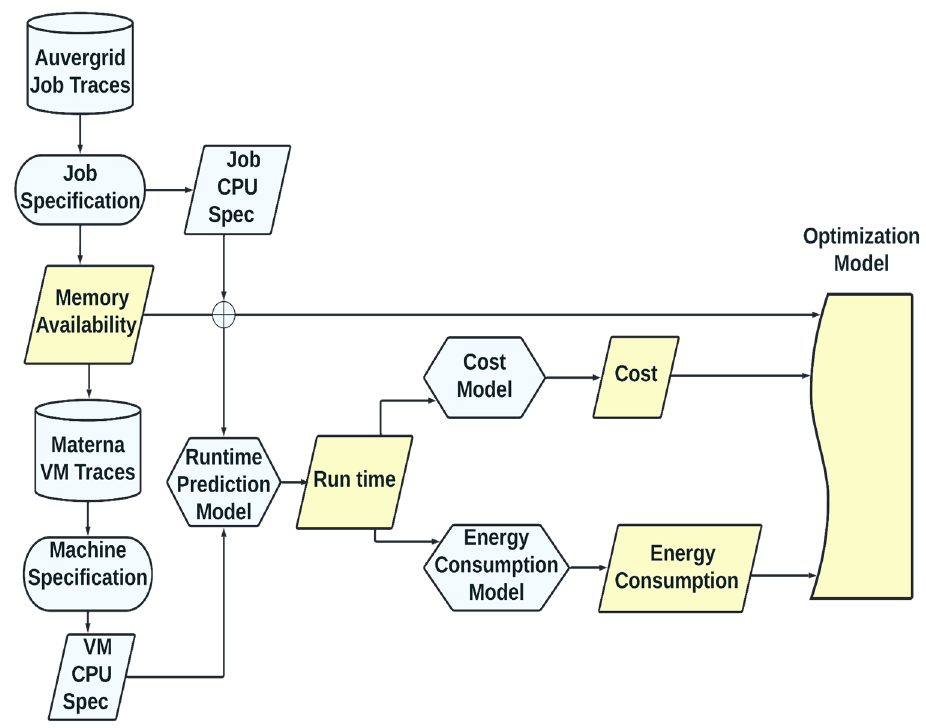
Figure 5. Dataflow diagram of our proposed OpERA resource allocation strategy.